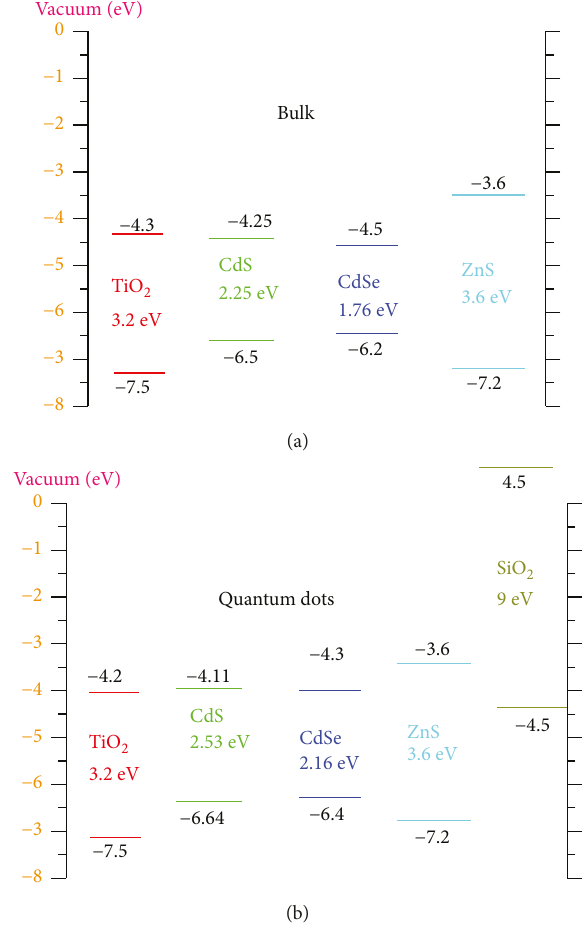
Figure 3: Energy levels alignment of the photoanode: (a) bulk and (b) quantum dots.